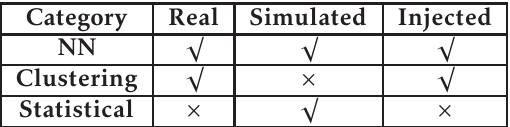
Table 8. Characteristics of anomaly detection algorithms